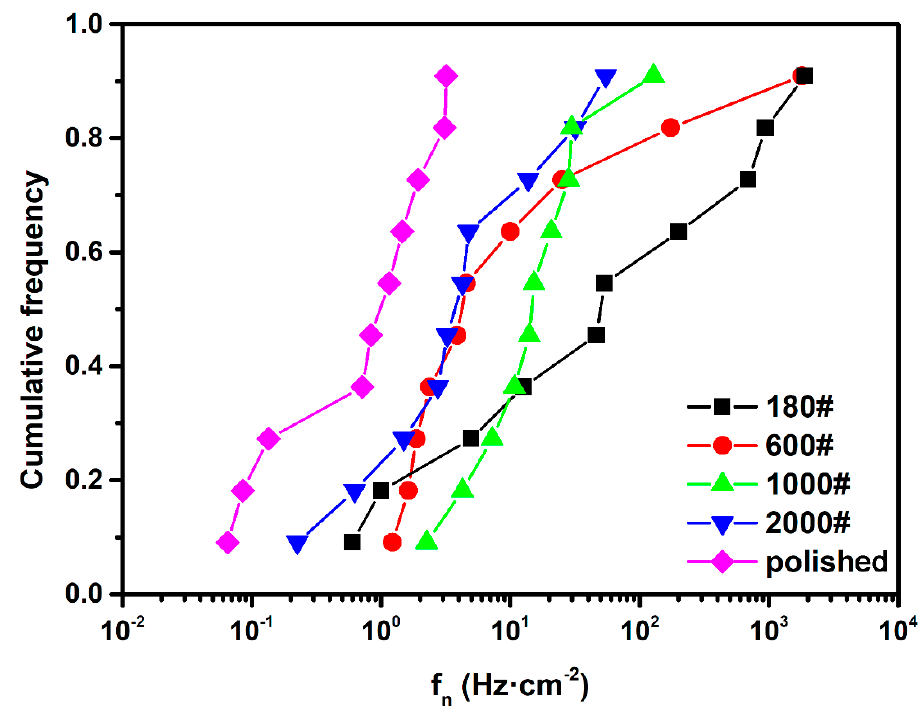
Figure 7. Cumulative frequency of f n for different surface roughness DSS 2205 specimens in 10% FeCl 3 at 50 °C.